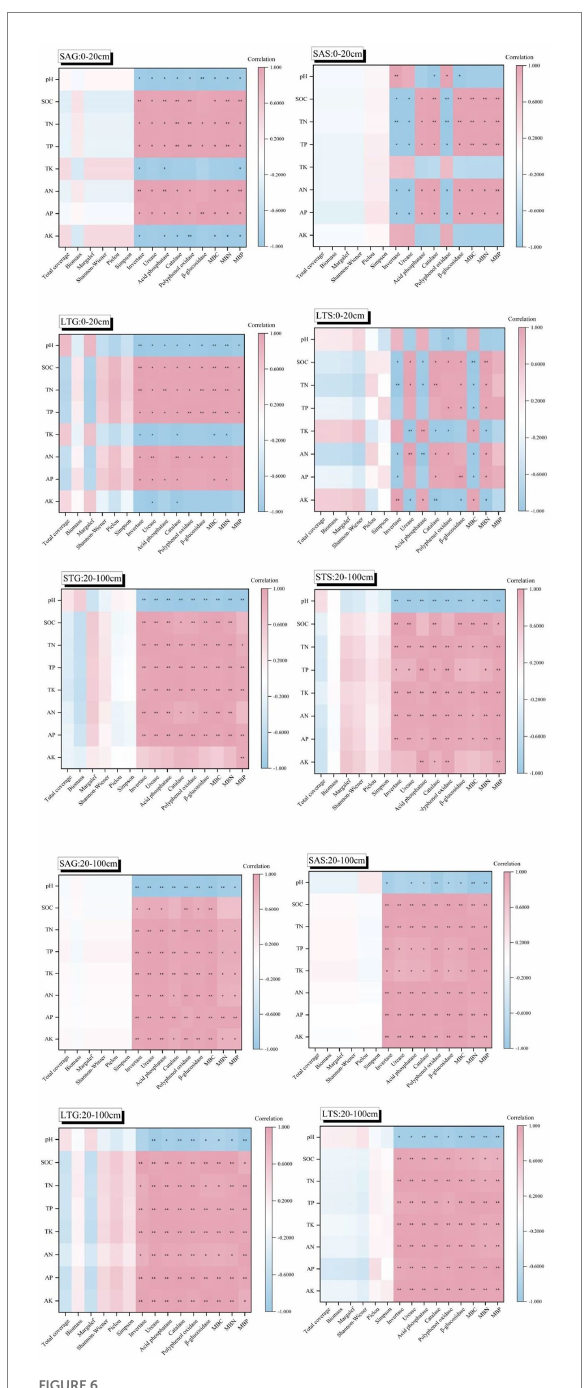
FIGURE 6 Relevance among vegetation characteristics, enzyme activity, and microbial biomass and soil nutrients under three shrub- encroached grasslands. ** indicates p < 0.01, * indicates p <